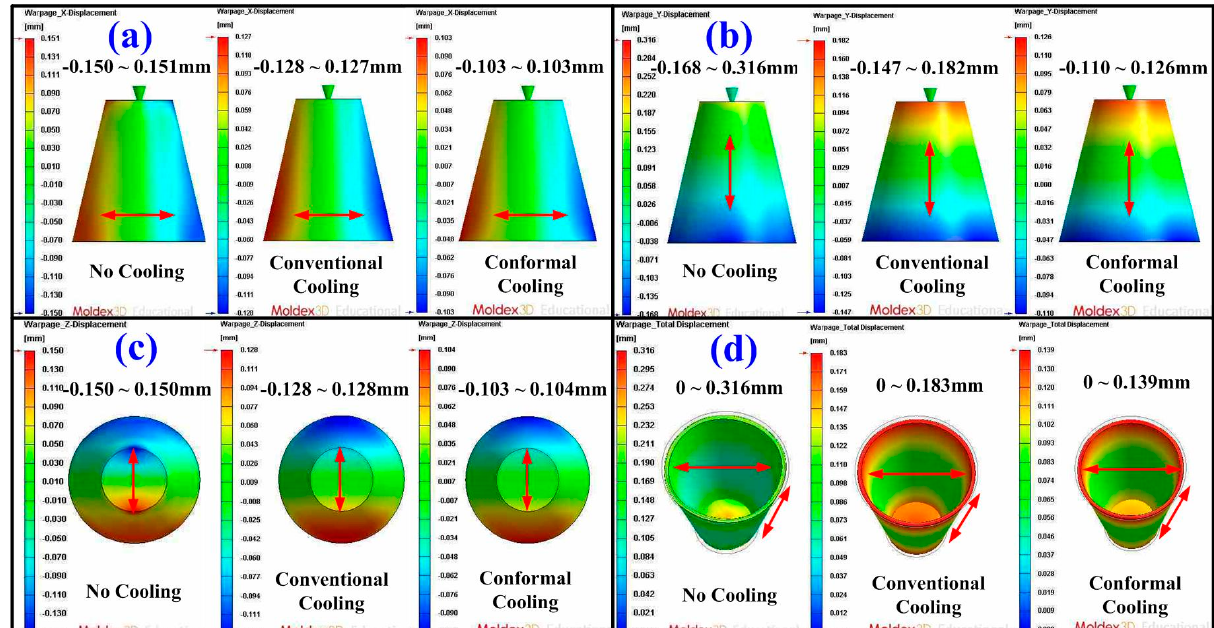
Figure 14. Numerical simulation results of total displacements in ( a ) x-direction, ( b ) y-direction, ( c ) z-direction, and ( d ) total directions.